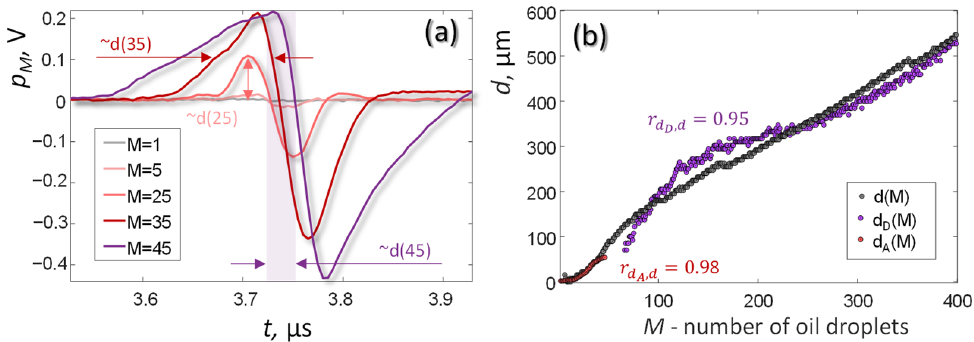
Figure 3. OA measurements of oil thickness. ( a ) OA waveforms for different oil thicknesses. ( b ) The comparison of d (cid:2885) (M) and d (cid:2888) (M) with d(M) values